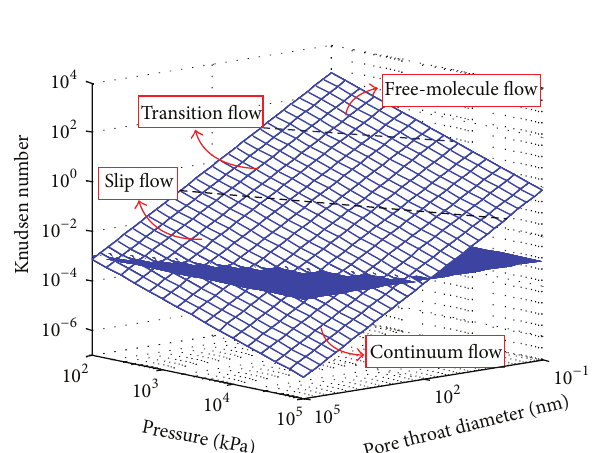
Figure 1: The relationship between Knudsen number, pressure, and pore